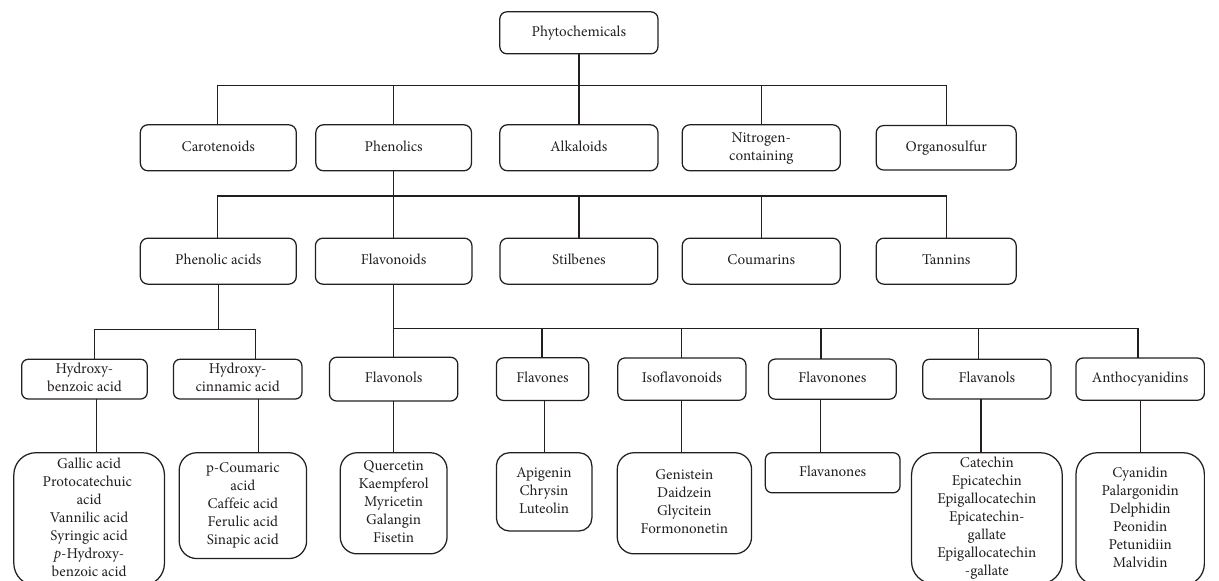
Figure 1: Classification of phytochemicals adapted from